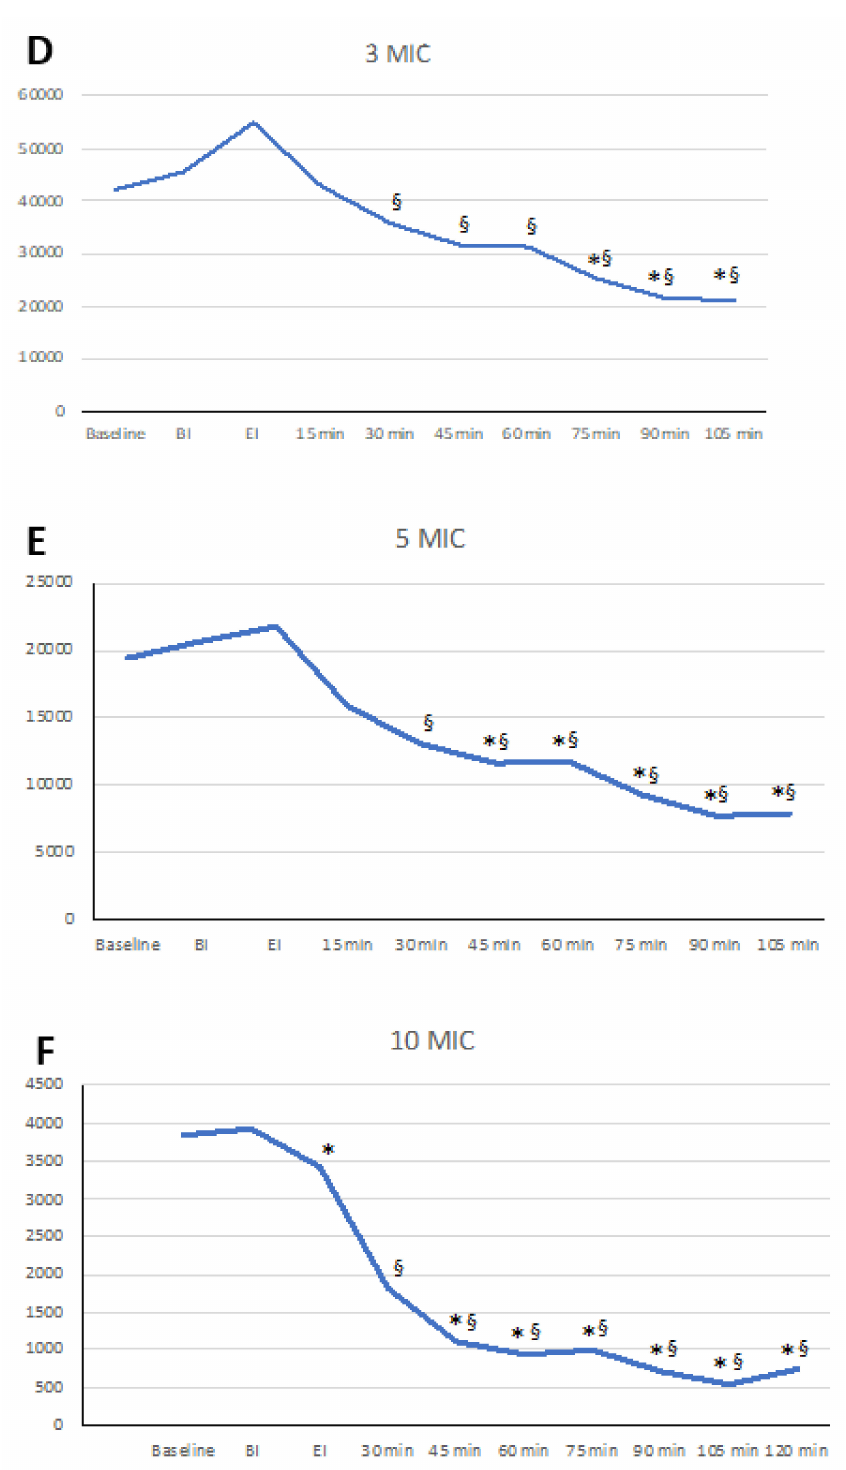
Figure 1. Linear graphs representing the dynamics of the aerosols after ultrasonic scaling. On the vertical axis, particle number is represented. Significant differences versus beginning of instrumenta- tion - BI (*) and end of instrumentation - EI (§) are marked. ( A ) P num of 0.3 µ m; ( B ) P num of 0.5 µ m; ( C ) P num of 1.0 µ m; ( D ) P num of 3.0 µ m; ( E ) P num of 5.0 µ m; ( F ) P num of 10.0 µ